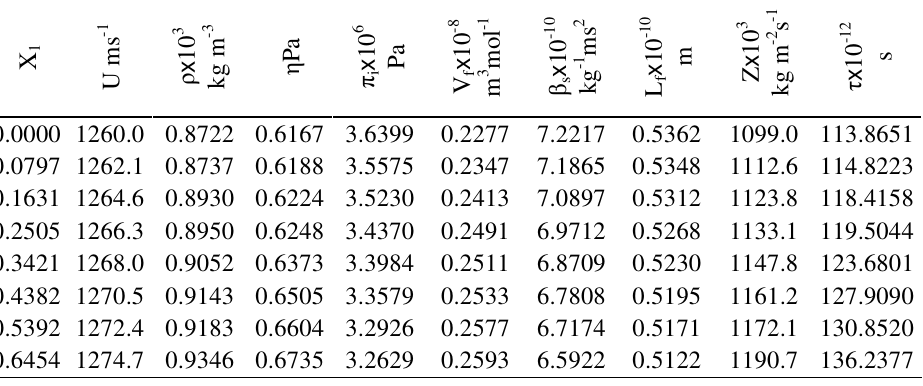
Table 1. Velocity (U), density ( ρ ), viscosity ( η ), internal pressure ( π adiabatic compressibility ( β of binary liquid systems I, II and III at 301